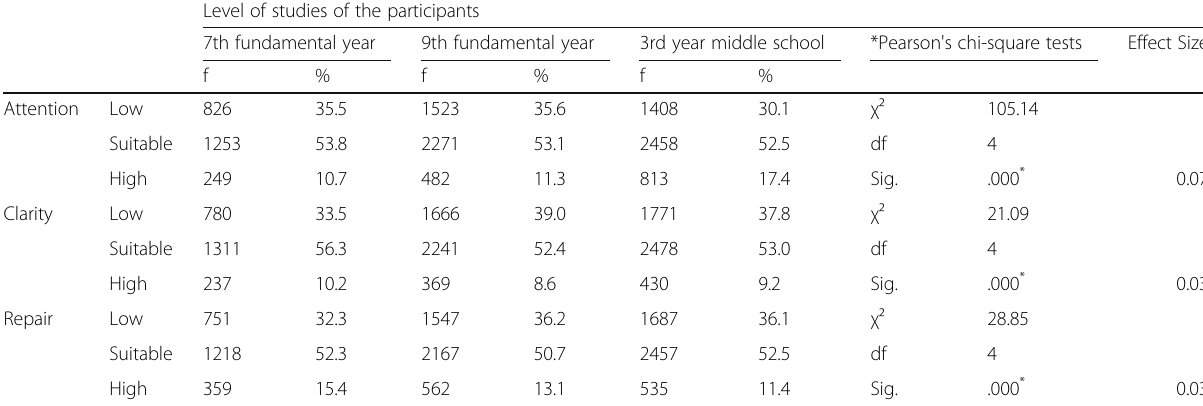
Table 4 Self-perception of emotional intelligence according to the level of studies of the participants. Test chi-squared and Effect sizes for Cramer ’ s